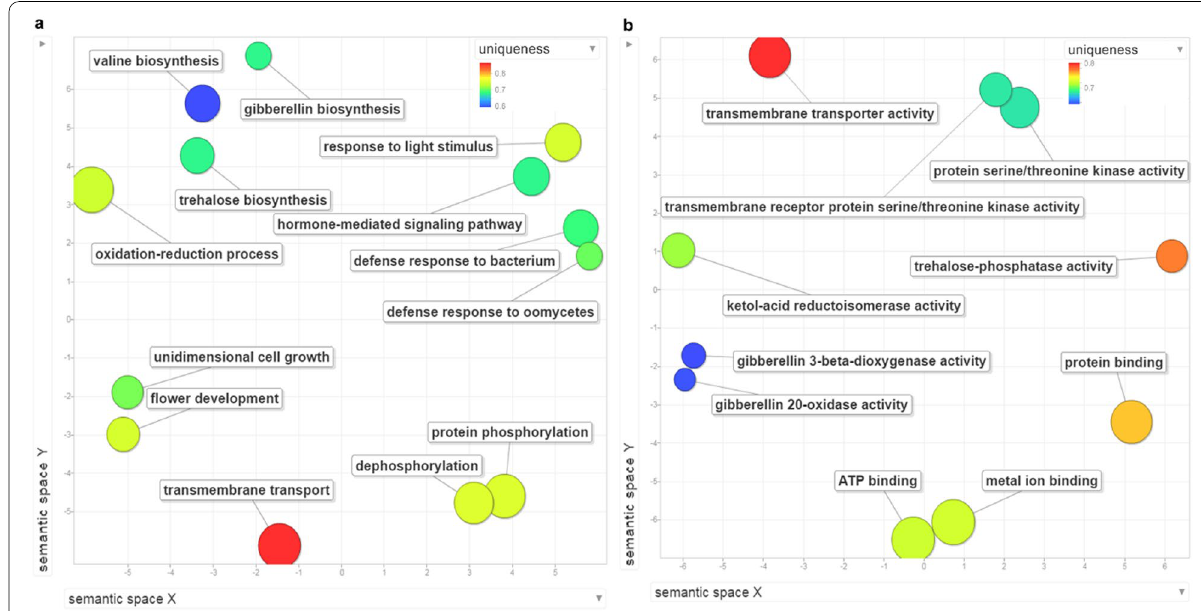
Fig. 4 REVIGO (Supek et al. 2011) visualization of GOs of genes under positive selection in TN1. a Biological process and b molecular function. These are the scatterplot of REVIGO showing the representative GO terms of the PS genes, where the colors of the circles represent the uniqueness value, computed from comparing each GO term to each other. The bigger the size of the sphere, the more the general the term